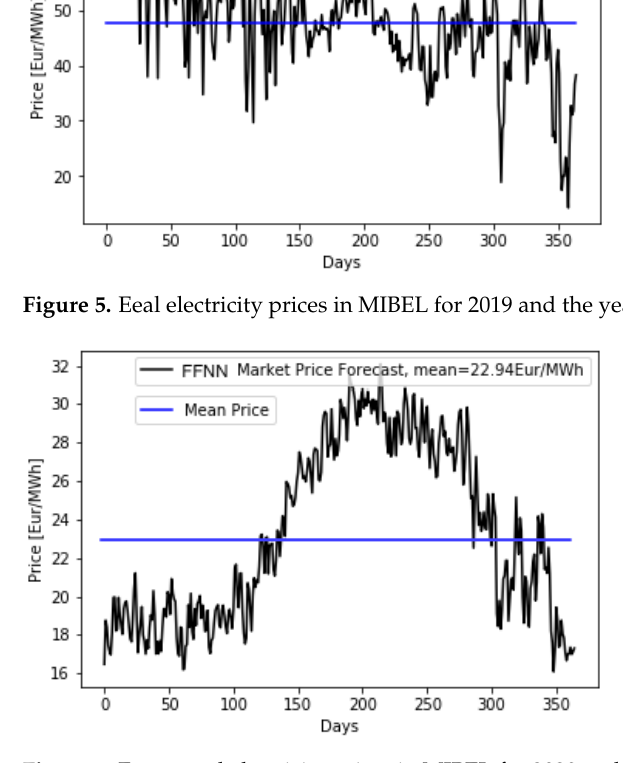
Figure 8. Hydro, solar, and wind (renewables) versus natural gas generation for 2030 in MIBEL.